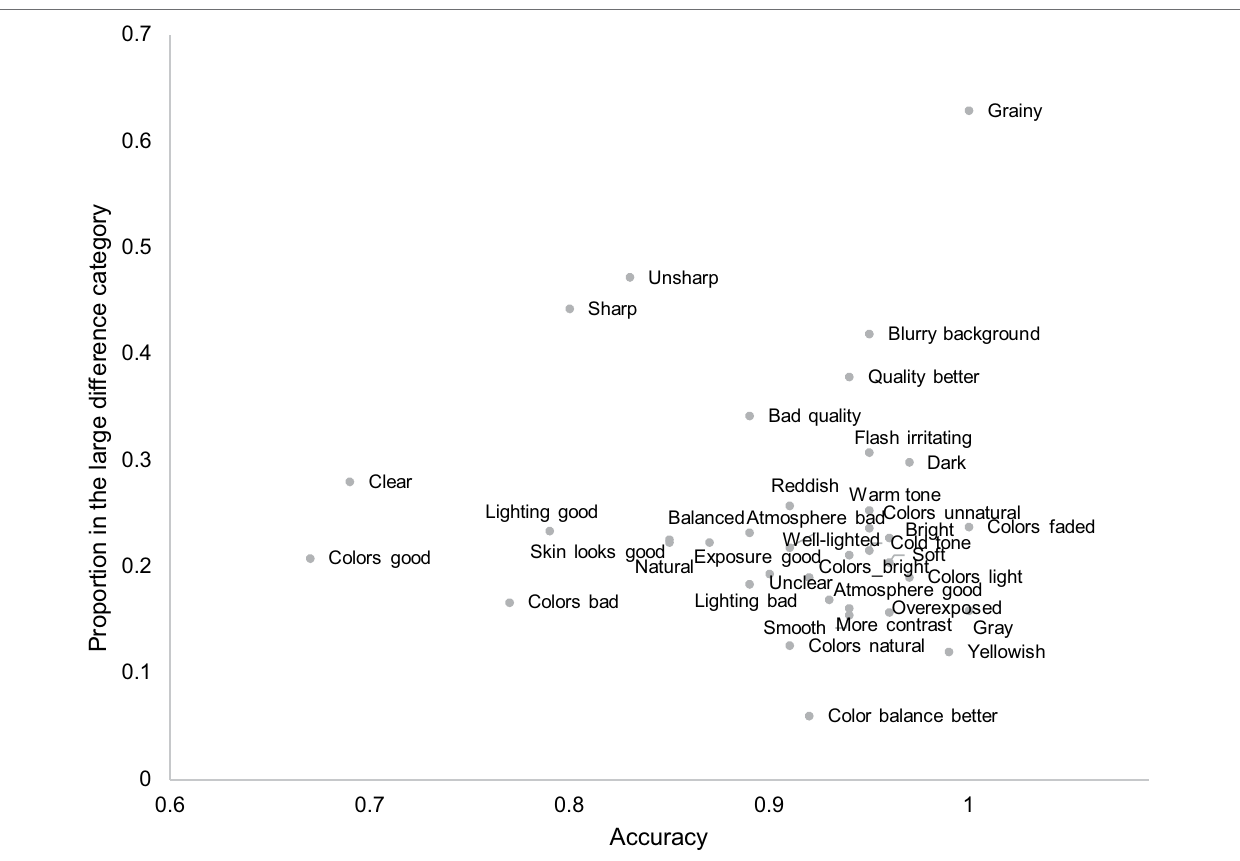
FIGURE 6 | Subjective attributes according to their accuracy and their proportion in the large difference category. Only attributes with frequency more than 31 are included; the accuracy estimation of rarer attributes is biased.